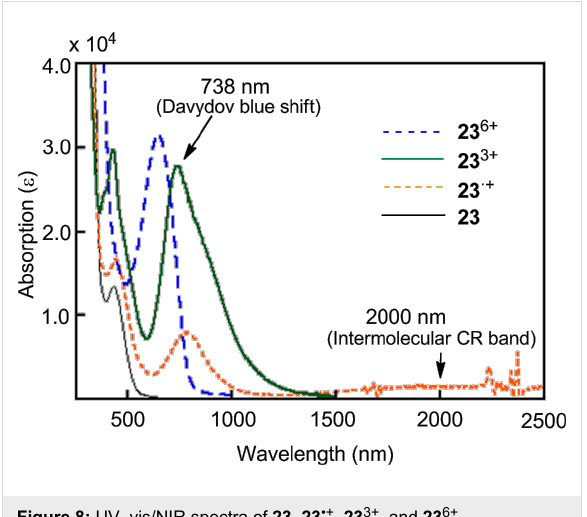
Figure 8: UV–vis/NIR spectra of 23 , 23 •+ , 23 3+ , and 23 6+ .